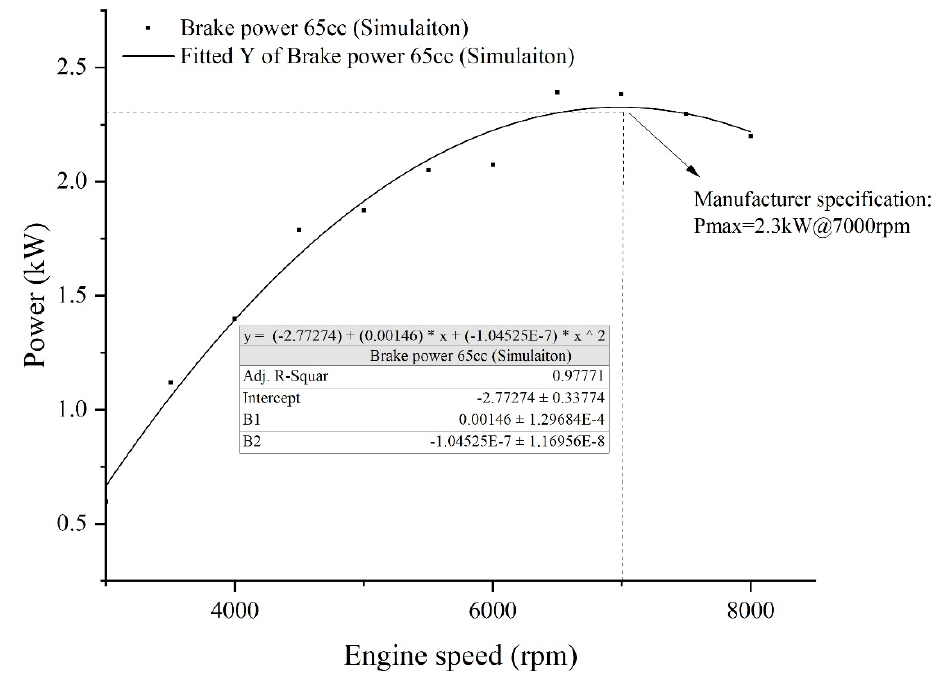
Figure 8. Fitted power curve of the four-stroke 65-cc engine as obtained from the Ricardo WAVE simulation.